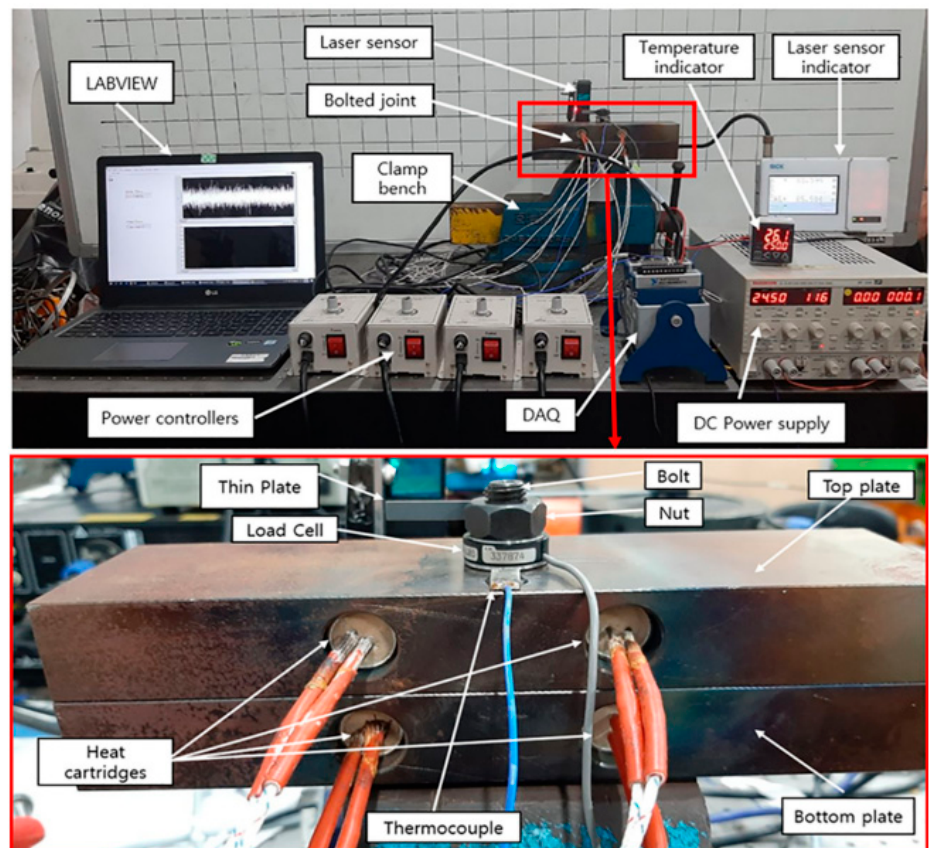
Figure 4. Experimental setup to study self-loosening due to temperature changes [44].